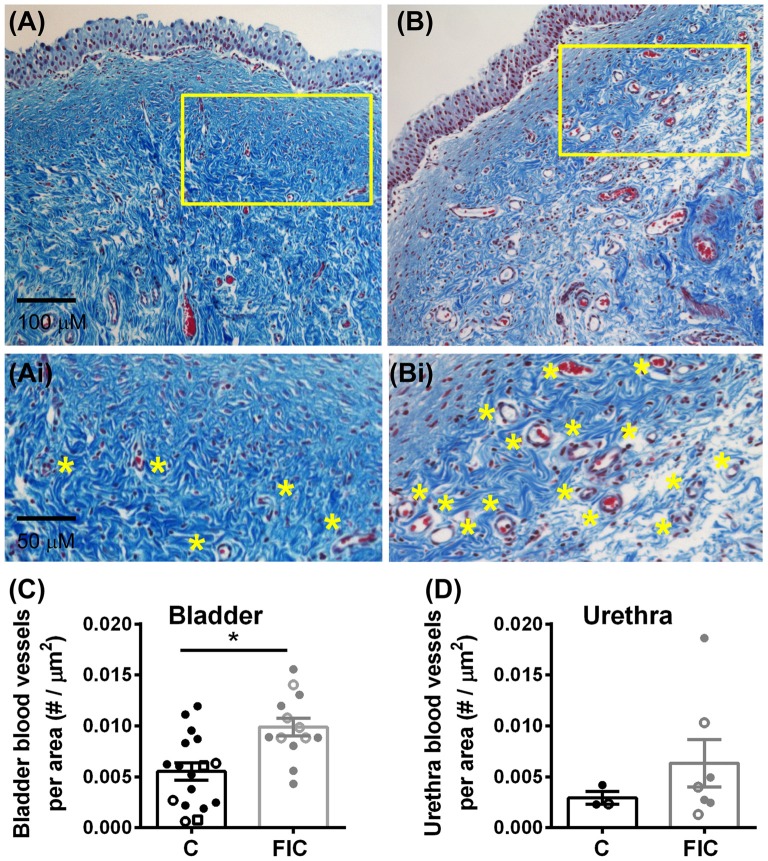
Increased angiogenesis in LP of the bladder and urethra. (A,B) Example of blood vessels in Mason trichrome stained tissues from control (A) and FIC (B) cat bladder. Insets (Ai,Bi) are magnified images of the areas outlined in yellow in (A,B), to illustrate blood vessels (indicated by yellow stars placed next to the vessels). (C,D) Number of blood vessels per area of tissue in the bladder (C) and urethra (D) from control (black; n = 17 bladder and n = 3 urethral tissues; Mann-Whitney test p = 0.024) and FIC (gray; n = 13 bladder and n = 7 urethral tissues; Mann-Whitney test p = 0.3) cats. Each symbol represents data from one animal. Open circles represent males, closed circles females and open squares represent undocumented sex. Statistical significance was tested using Mann-Whitney test. Asterisk (*) indicates p < 0.05.